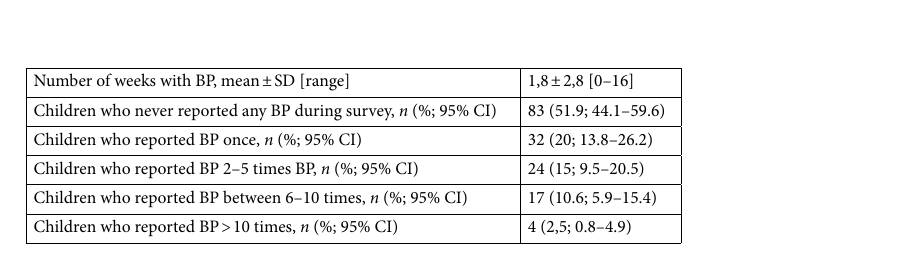
BP prevalence during the 8-month follow-up, n (%; 95% CI) 77 (48.4; 40.7–56.2) Never reported any BP before or during the study, n (%; 95 CI) Prior history of BP, but none during follow-ups, n (%; 95% CI) BP cumulative incidence (first BP episode) at 8-month, n (%) Table 2. BP description during the 8-month follow-up, and proportion of children who never reported any BP among responders ( n = 159).